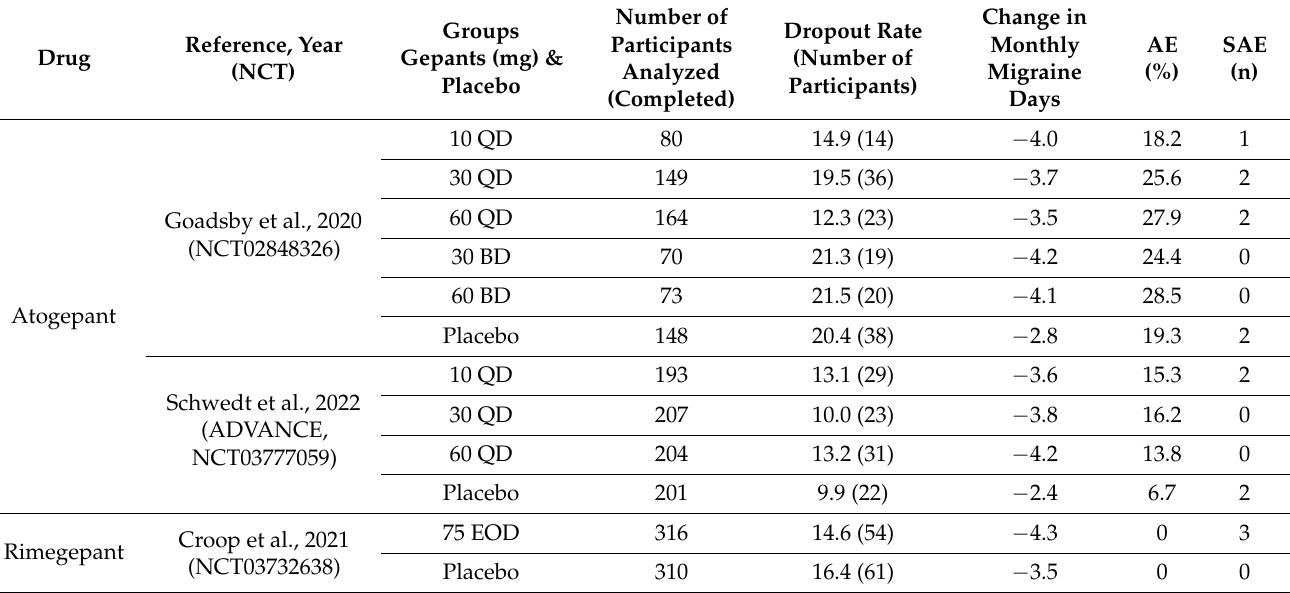
Table 3. Clinical trials of gepants indicated for preventive migraine